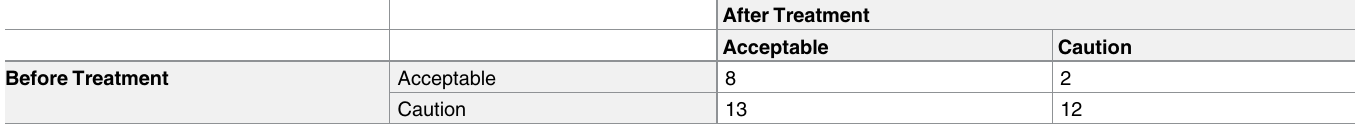
After Treatment Acceptable Caution